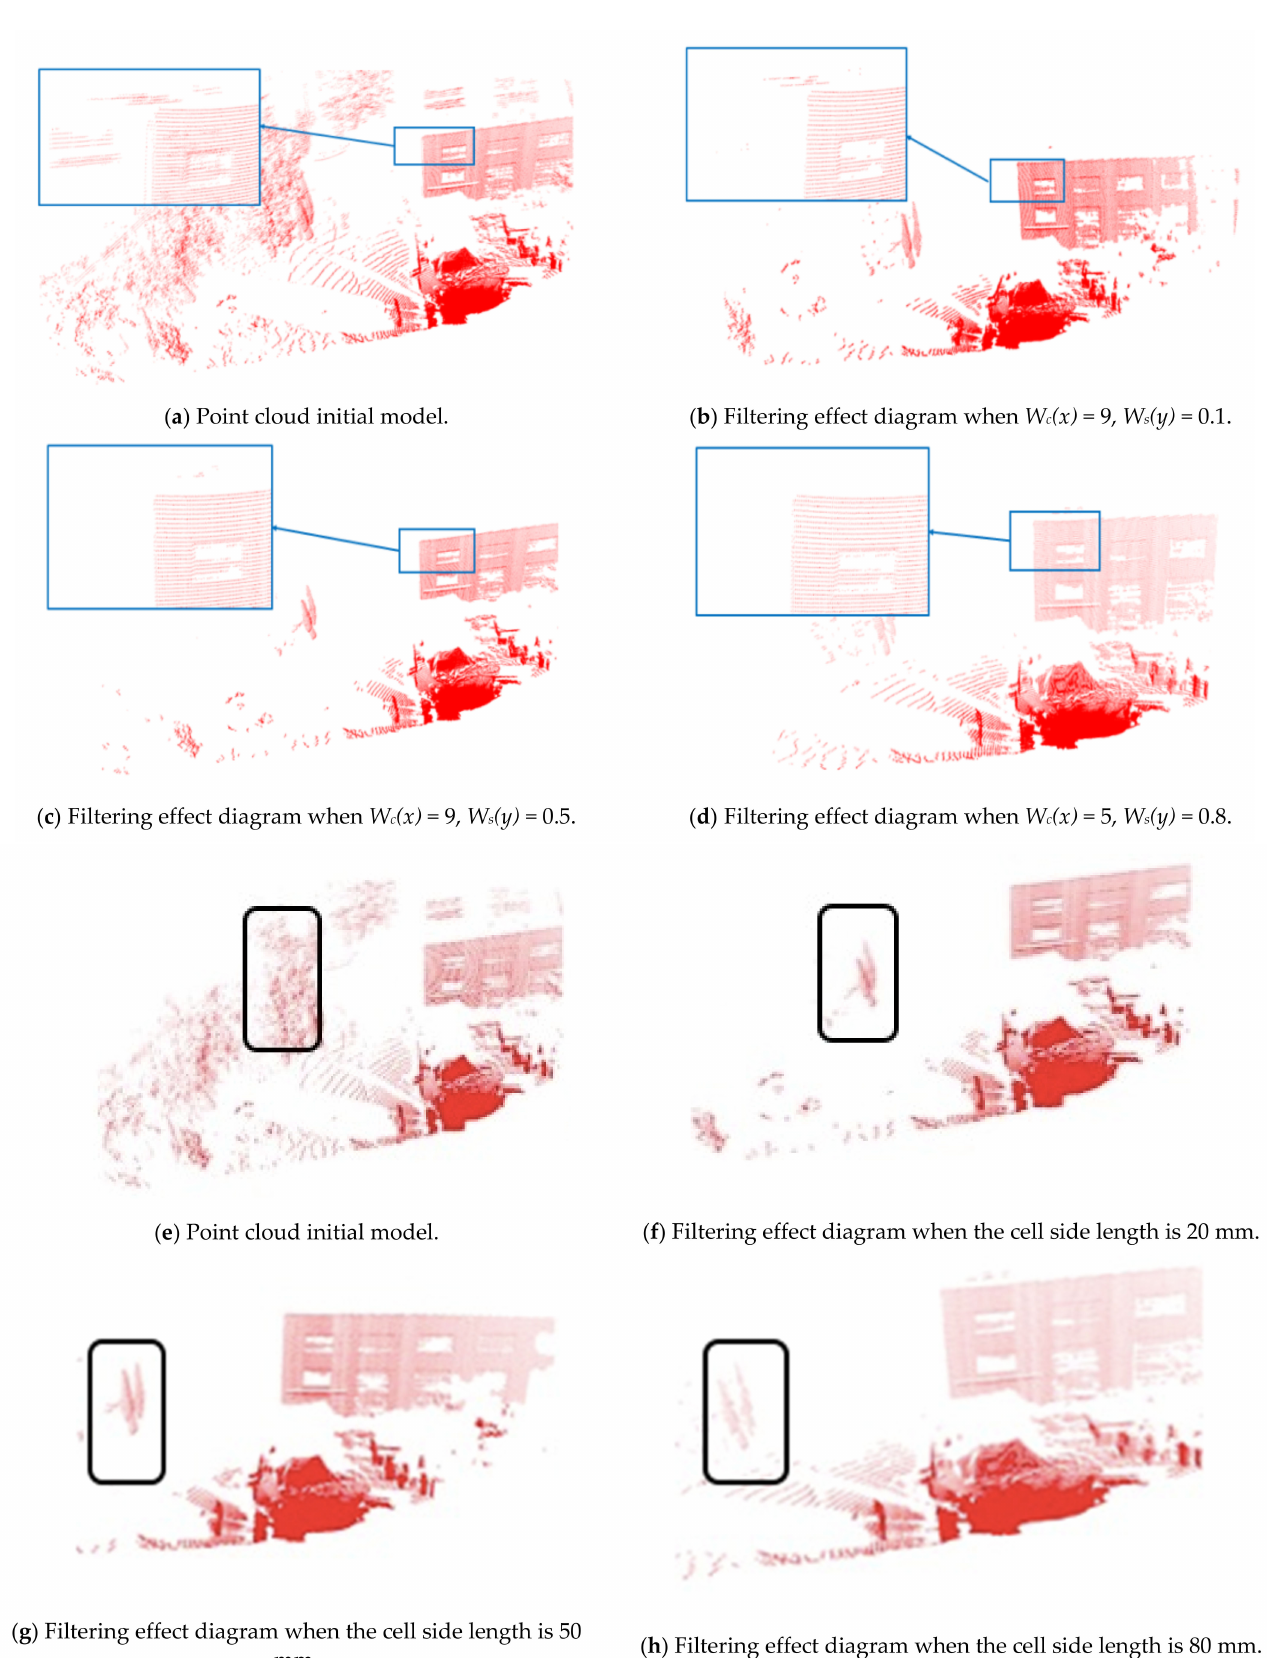
Figure 7. Bilateral filtering, removing outliers and Gaussian denoising effect of point cloud model under different